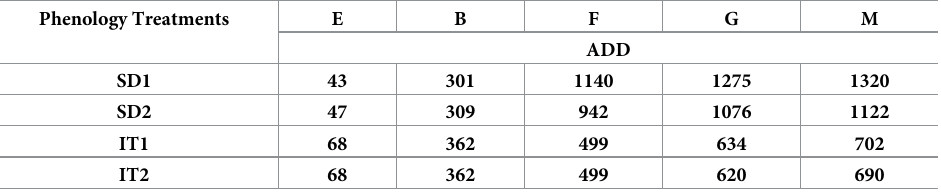
Table 1. Accumulated degree days (ADD) for sowing date (SD1 and SD2) and water availability (IT1 and IT2) during the phenological development of the crop in Antumapu and Intihuasi, respectively. Phenology Treatments